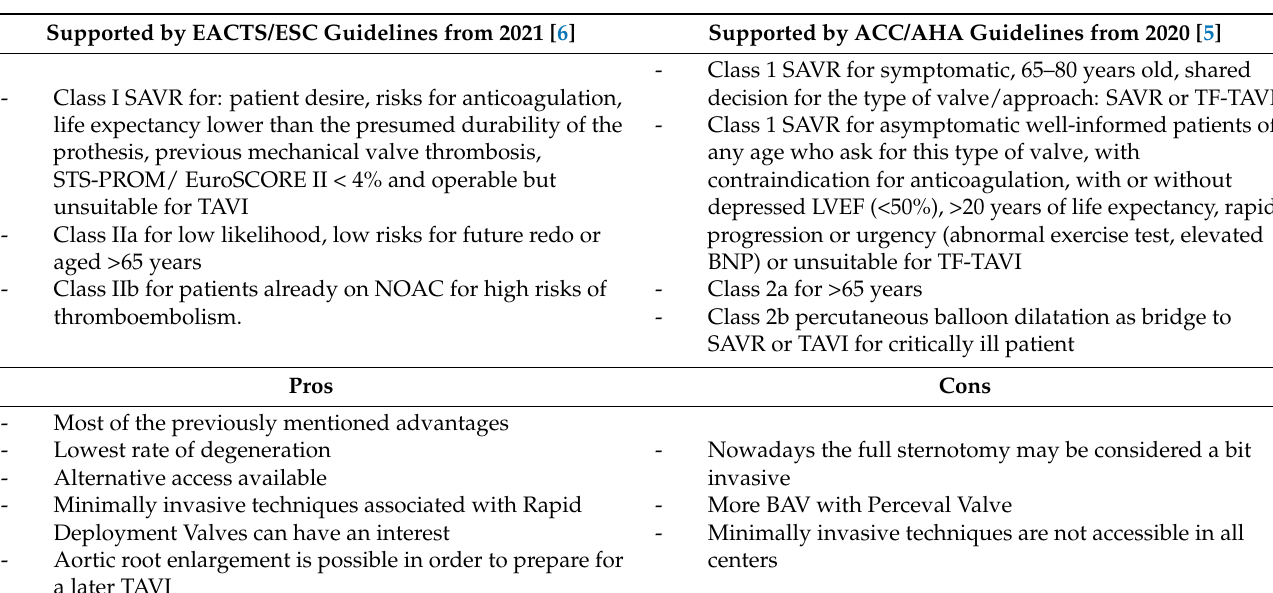
Table 8. Decision Making Algorithm. Bio-AVR for older patients.